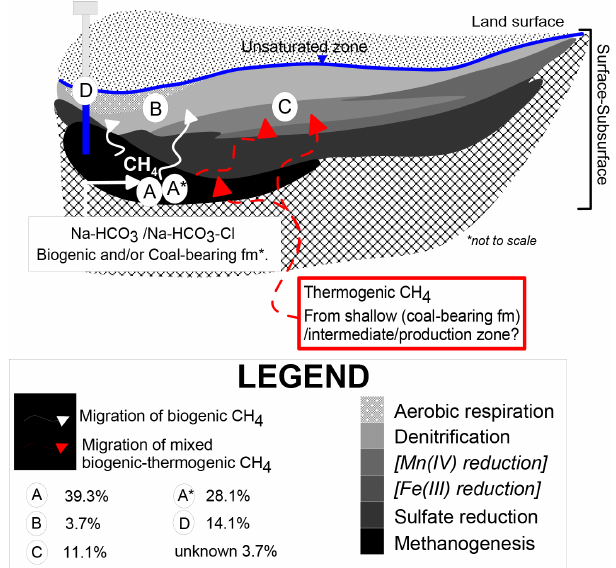
Figure 13. Geochemical and multi-isotopic approach applied in this study to classify the methane type/occurrence considering the redox zoning